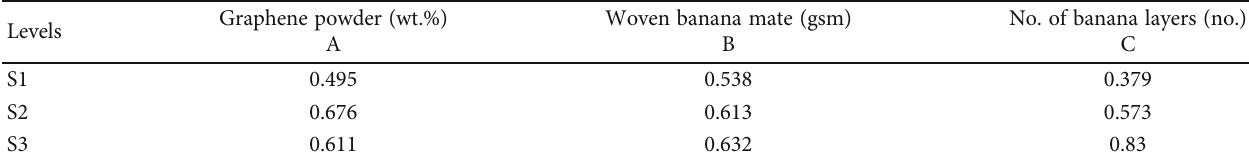
Table 6: Retort table for